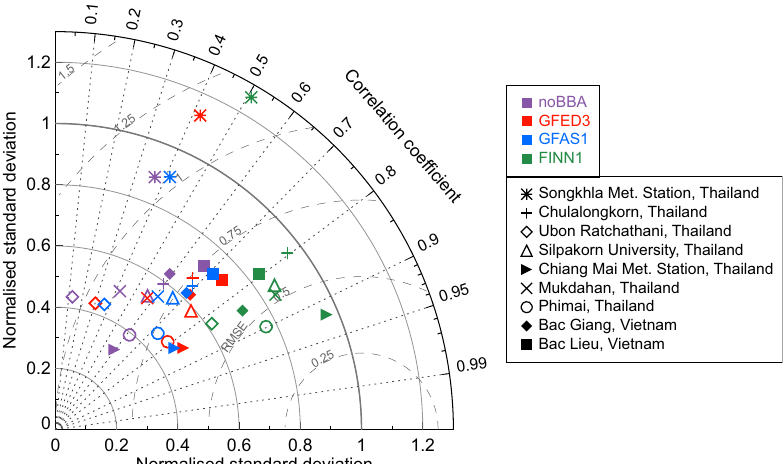
Figure 8. Taylor diagrams (Taylor, 2001) comparing monthly mean modelled and observed AOD (440nm) at 9 AERONET stations located in Indochina. The modelled and observed monthly mean AODs were calculated for every month with available daily mean data between January 2003 and December 2011. The observations are represented by a point on the x axis at unit distance from the y axis. The results are shown for four simulations: without biomass burning (purple), and with GFED3 (red), GFAS1 (blue) and FINN1 (green) fire emissions. The model standard deviation and root-mean-square error (RMSE) are normalised by dividing by the corresponding observed standard deviation. The normalised standard deviation and RMSE values are marked by the solid grey and dashed grey lines respectively. The correlation coefficient ( r ) values are marked by the dotted grey lines.